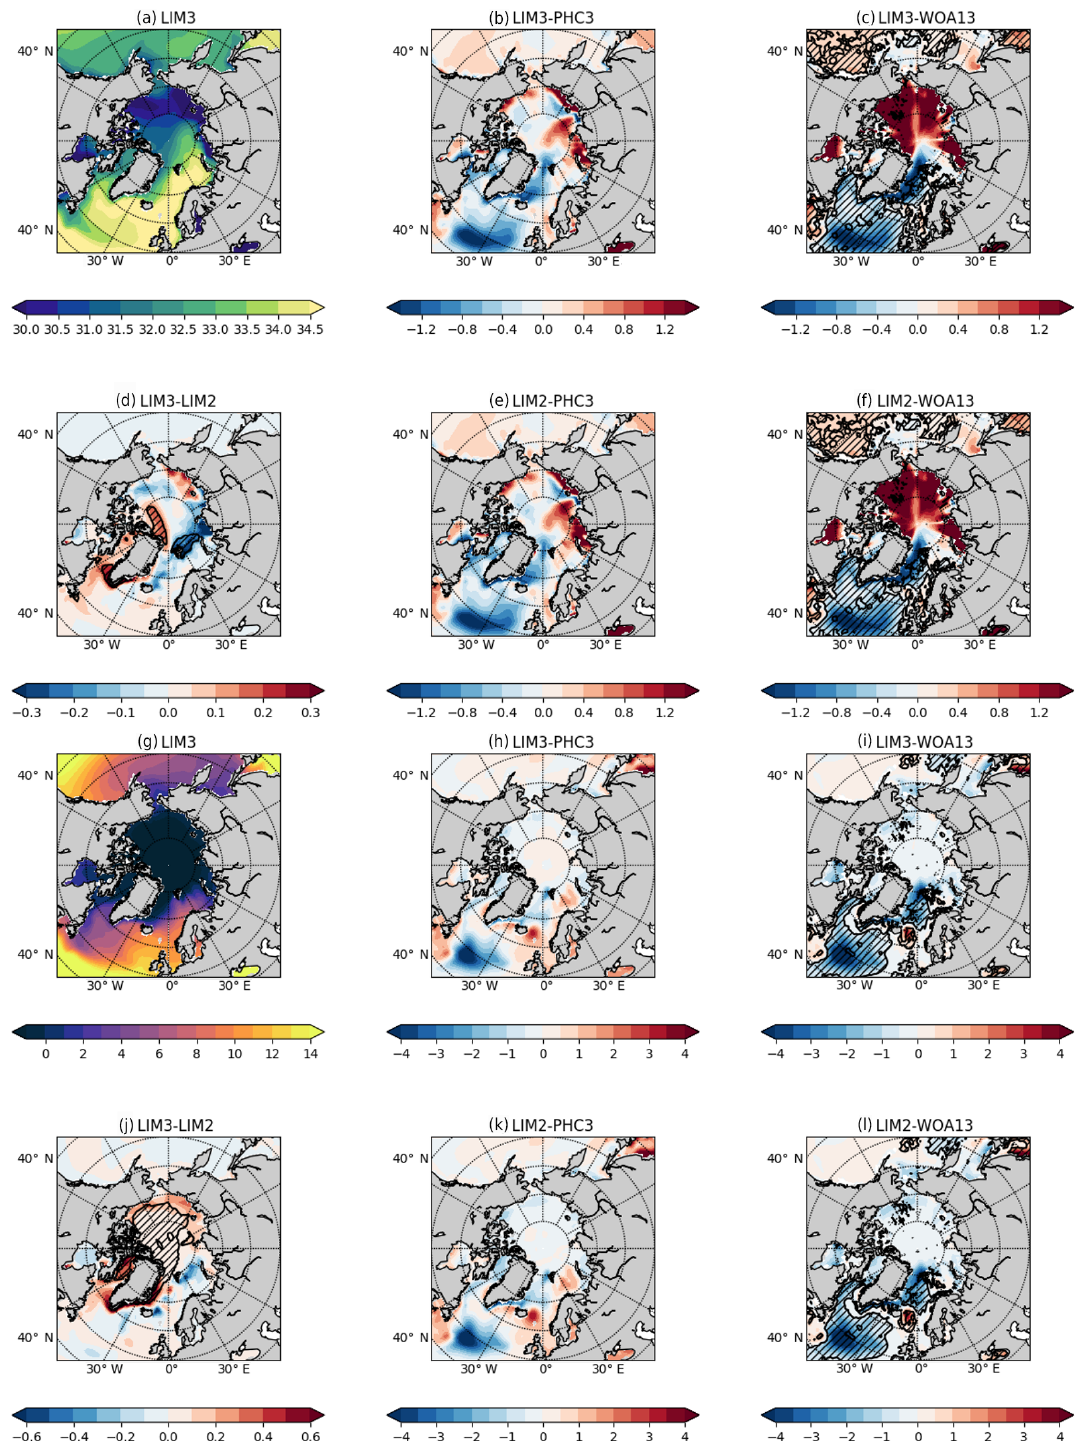
Figure 5. (a–f) Arctic sea surface salinity in psu (SSS) and (g–j) sea surface temperature in ◦ C (SST) averaged over the period of 2003–2012. (a, g) show the LIM3 averages, (b, h) the difference between PHC3 (Steele et al., 2001) and LIM3, (c, i) the difference between WOA13 (Boyer et al., 2013) and LIM3, (e, f, k, l) the corresponding differences for LIM2, and (d, j) show the differences between LIM3 and LIM2. WOA13 data are averaged over the years 2005–2013, while PHC3 data contain observations from 1900 to 1998, as in WOA98, plus all Arctic observations until 2004. Hatching indicates regions with statistically significant differences at the 5% level based on unequal variances t test. As PHC3 does not include standard deviation and sample size, the statistical significance levels of LIM–PHC3 differences could not be